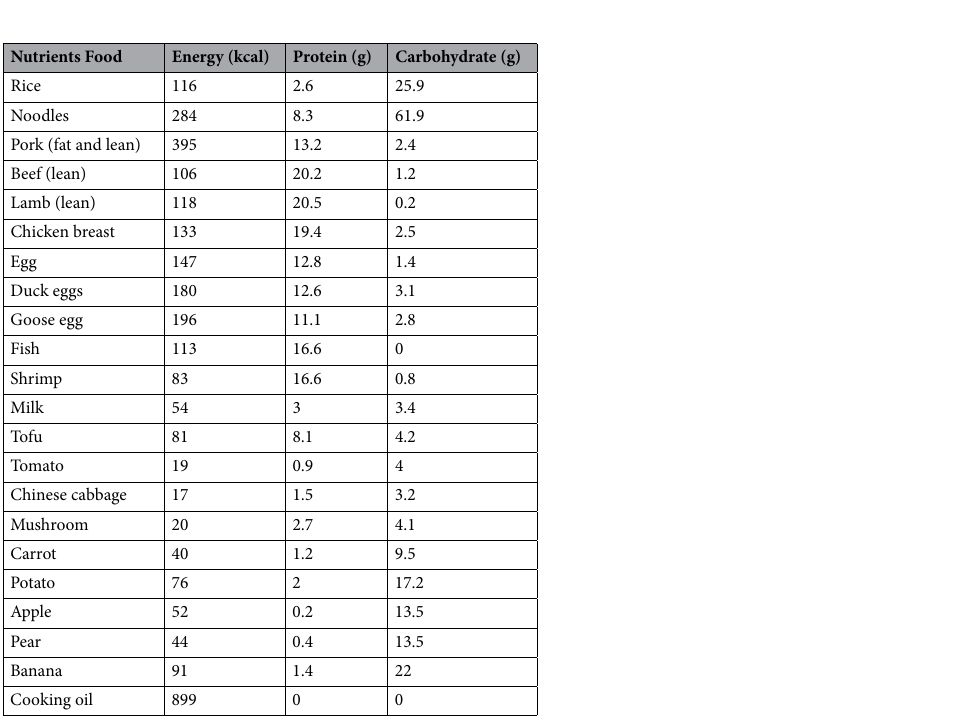
Table 4. The value of three nutrients per 100 g of each kind of